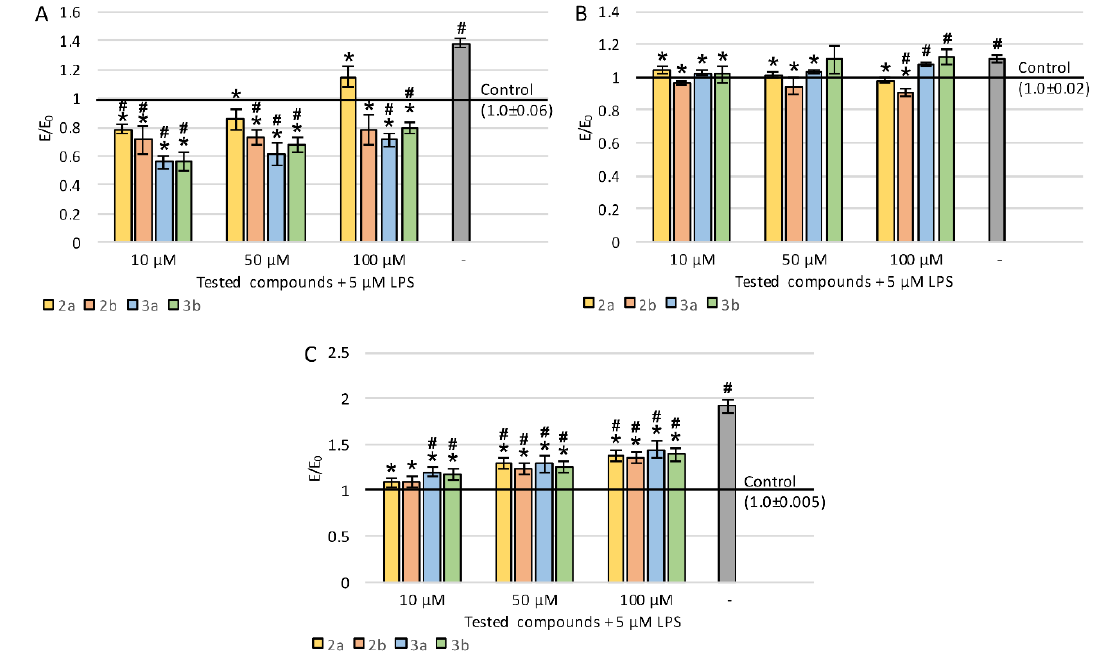
Figure 6. The effect of tested compounds on PC12 cell culture incubated with LPS: A ) DCF-DA assay, B ) Griess assay, C ) fast halo assay; Control—cell culture incubated without LPS and tested substances; * p < 0.05—significant difference compared to control preincubated with LPS; # p < 0.05—significant difference compared to the negative control without LPS.